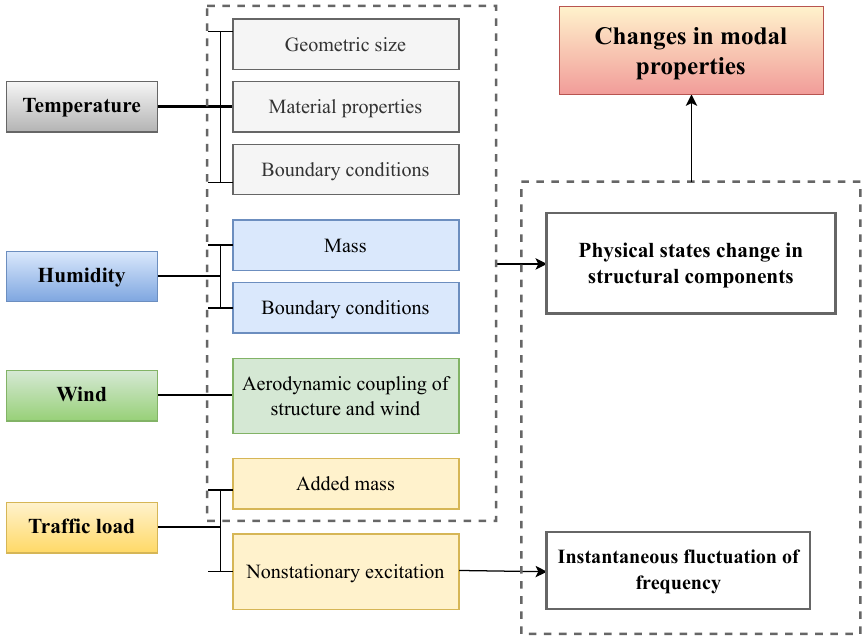
Figure 5. Influence mechanisms of EOCs on modal properties